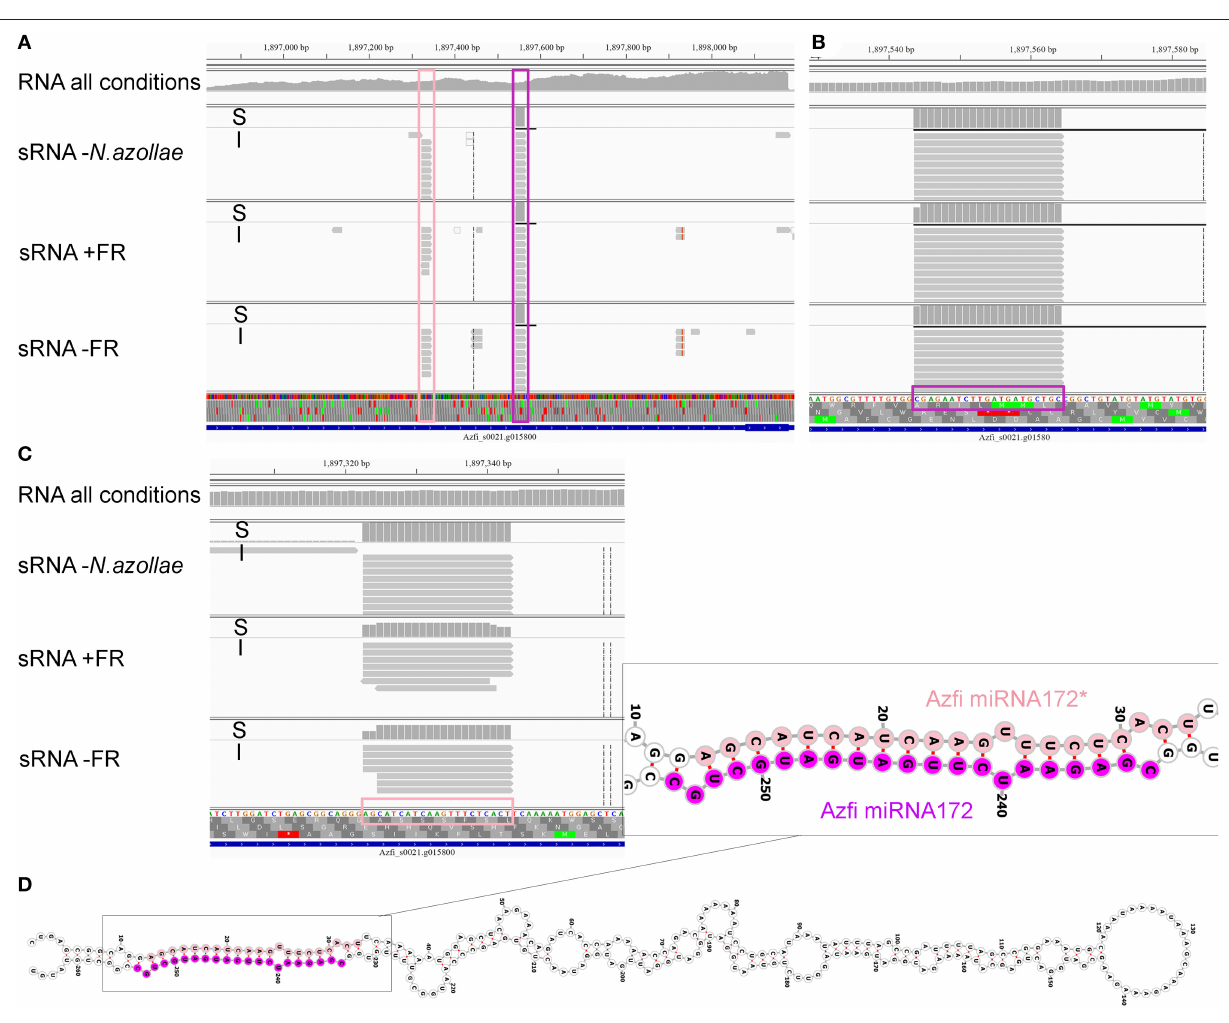
FIGURE 6 | The microRNA (miRNA) 172a locus in A. filiculoides . Alignments at the Azfi_miRNA172a locus are visualized using the Integrative Genomics Viewer (Thorvaldsdóttir et al., 2013); S, read summary; I, individual reads. (A) Reads from pre-miRNA at the miR172a locus. RNA-seq all conditions, all reads pooled from the dual RNA-seq experiment in Brouwer et al. (2017). (B) Reads of the miR172 in sRNA libraries including those of ferns without N. azollae (sRNA-seq— N. azollae ), ferns grown with and without FR (sRNA-seq + FR, sRNA-seq TL-FR). (C) Reads of the miR172*. (D) Azfi_miRNA172a hairpin folded using Vienna RNAfold (Gruber et al., 2008; predicts − 104.07 kcal mol − 1 at 22 ◦ C upon folding); miRNA (purple) and miRNA* (pink) stem arms are shown with